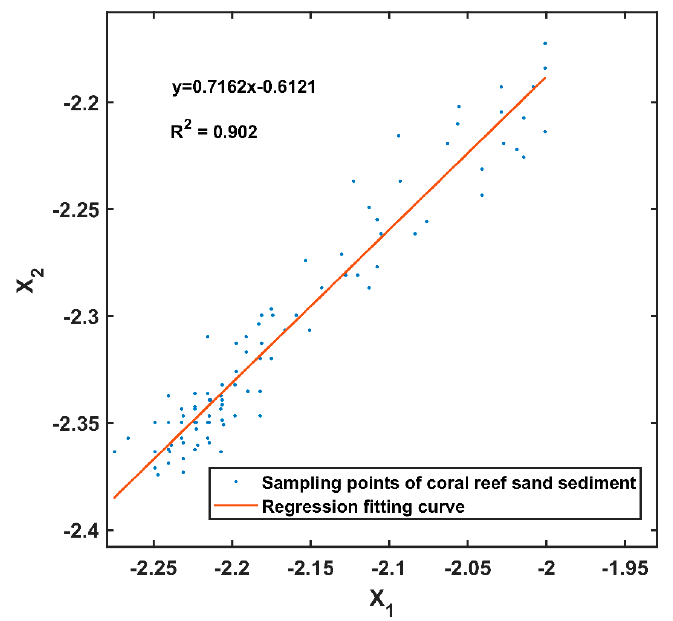
Figure 2. X1~X2 sampling points of the same sediment at varying water depths (Ganquan